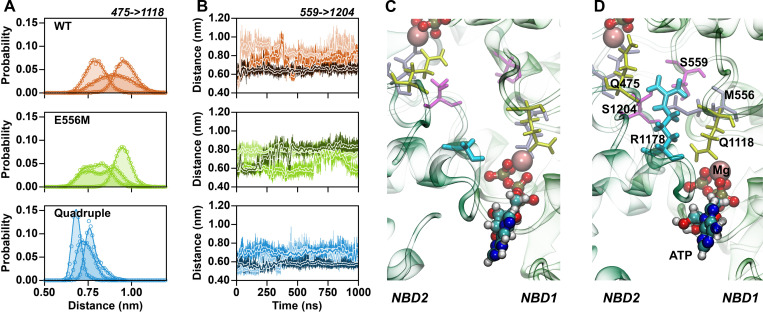
The guanidinium moiety of G1178R interacts with both Q-loops.(A) Distribution of distances between the Q-loop carbonyl oxygens of Q475 and Q1118. Data from independent trajectories for wild type simulations are shown in orange, the trajectories of the catalytic glutamate mutant are shown in green, and data for the quadruple mutant are shown in blue. (B) Time evolution of distances between the Cα atoms of the D-loop serines S559 and S1204. (C) Relative D-loop orientation shown for wild-type ABCB1, highlighted by D-loop serines S559 and S1204 (magenta). (D) Representative position of the guanidinium group of G1178R (cyan) forming hydrogen bonds with the backbone carbonyl of Q-loop glutamines (yellow).